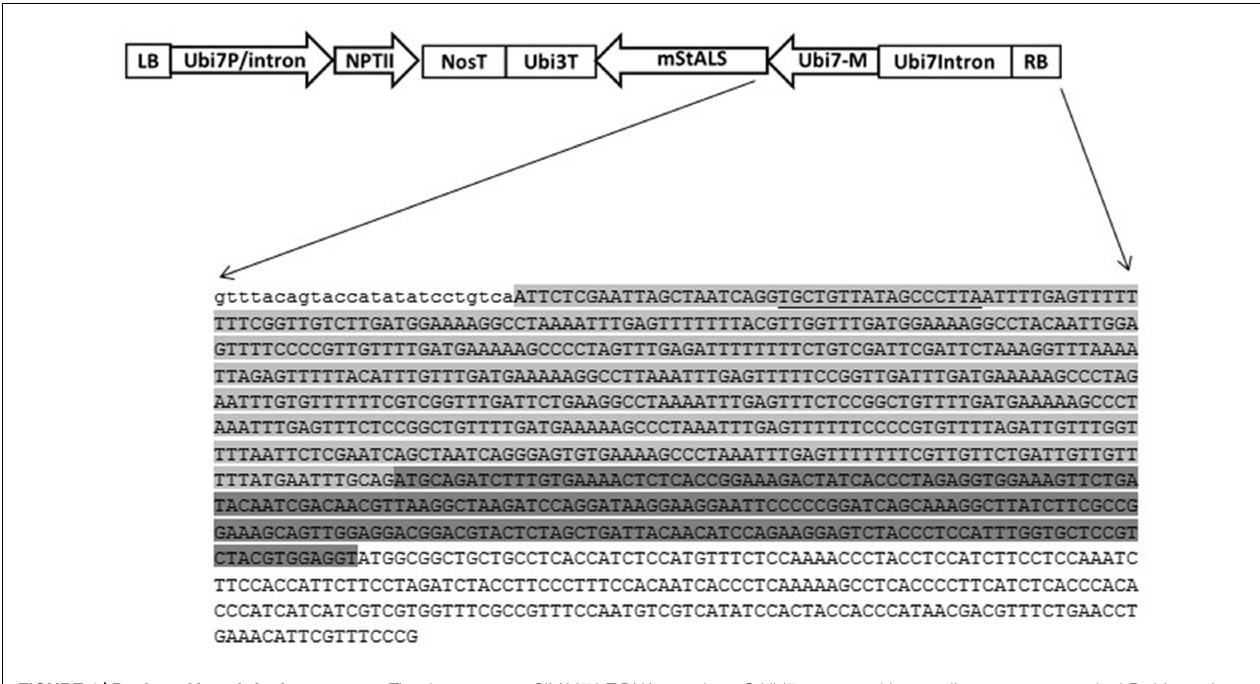
FIGURE 4 | Design of knock-in donor vector. The donor vector pSIM2370 T-DNA contains a StUbi7 promoter driven nptII gene cassette at the LB side, and a promoter-less m StALS gene at the RB side. At the sequence level, next to the RB, are sequences of a partial Ubi7 5 (cid:48) intron region (light gray highlighted), Ubi7 monomer (dark gray highlighted) fused to the mStALS coding sequence (only partial sequence is shown in this figure). The intron sequence contains a spacer between the two TALEN binding sites and the second TALEN recognition site (underlined). There is no ipt expression cassette on the backbone of donor